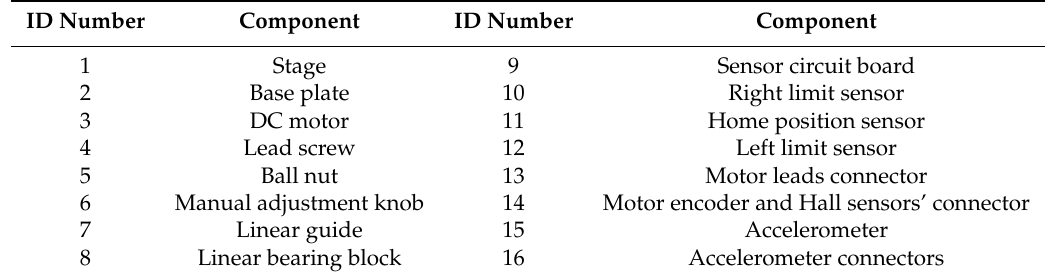
Figure 2. Shake Table II components. Table 2. Shake Table II